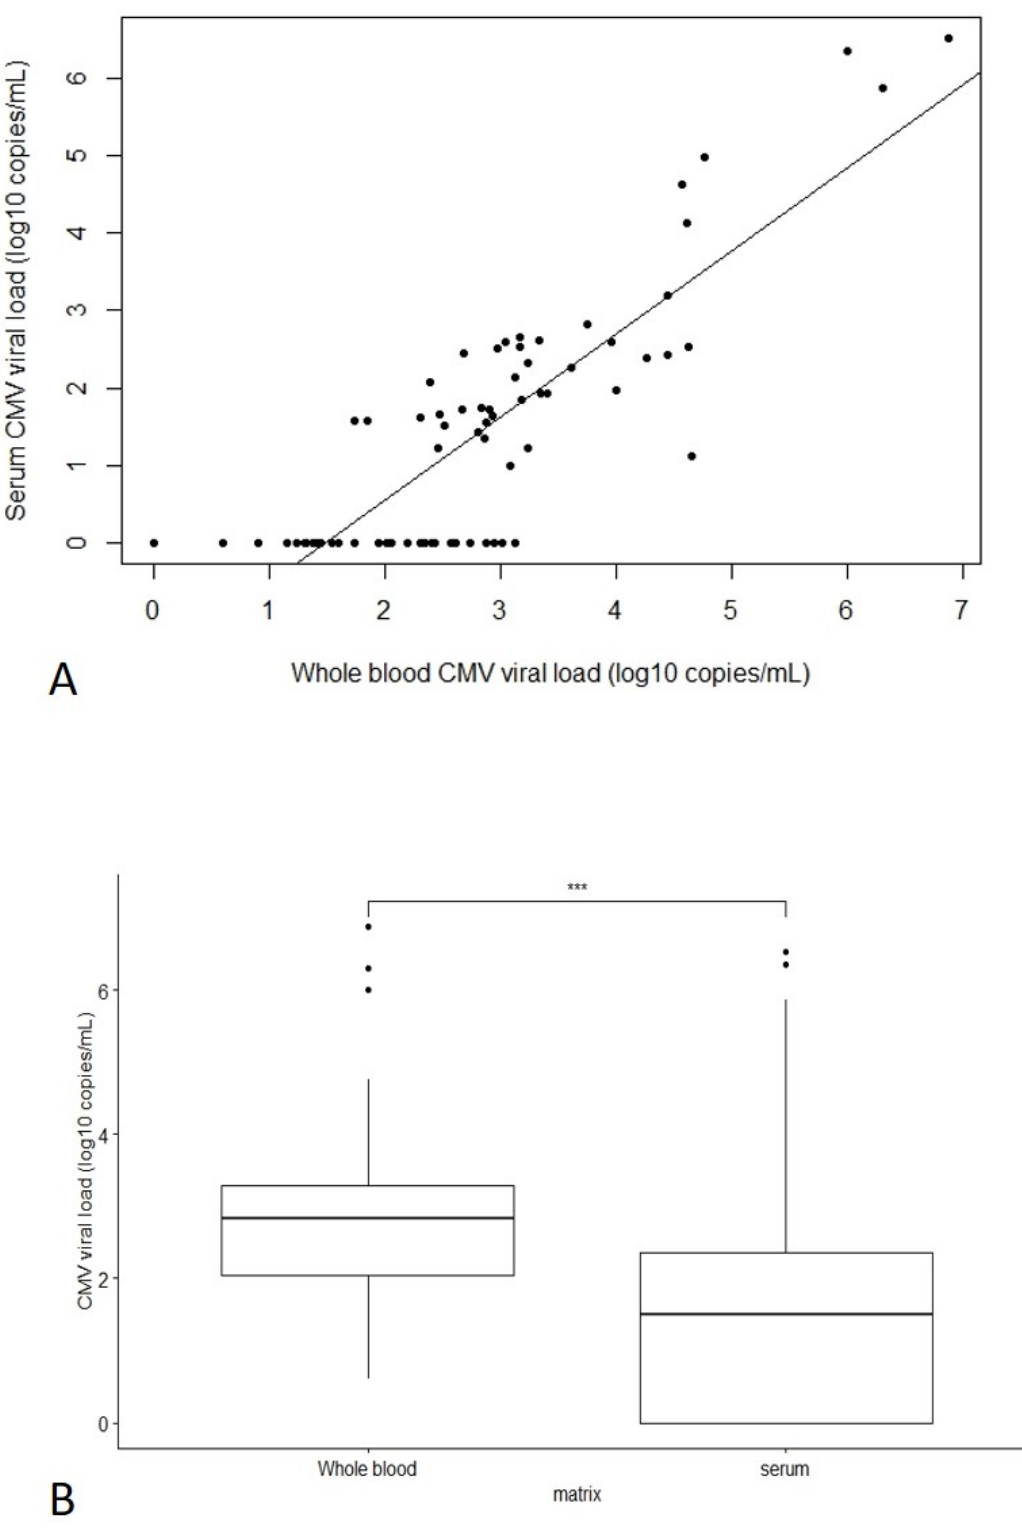
Figure 2. Comparison of Quantitative CMV PCR in Whole Blood versus Serum. ( A ) Plot of correlation between CMV viral load in serum versus whole blood, with linear regression line. PCR undetectable in serum was plotted at 0. Estimated R 2 was 0.71. ( B ) Boxplot for comparison between CMV viral load in whole blood and serum. Significant difference of means (***) observed using the Wilcoxon test ( p < 0.001).